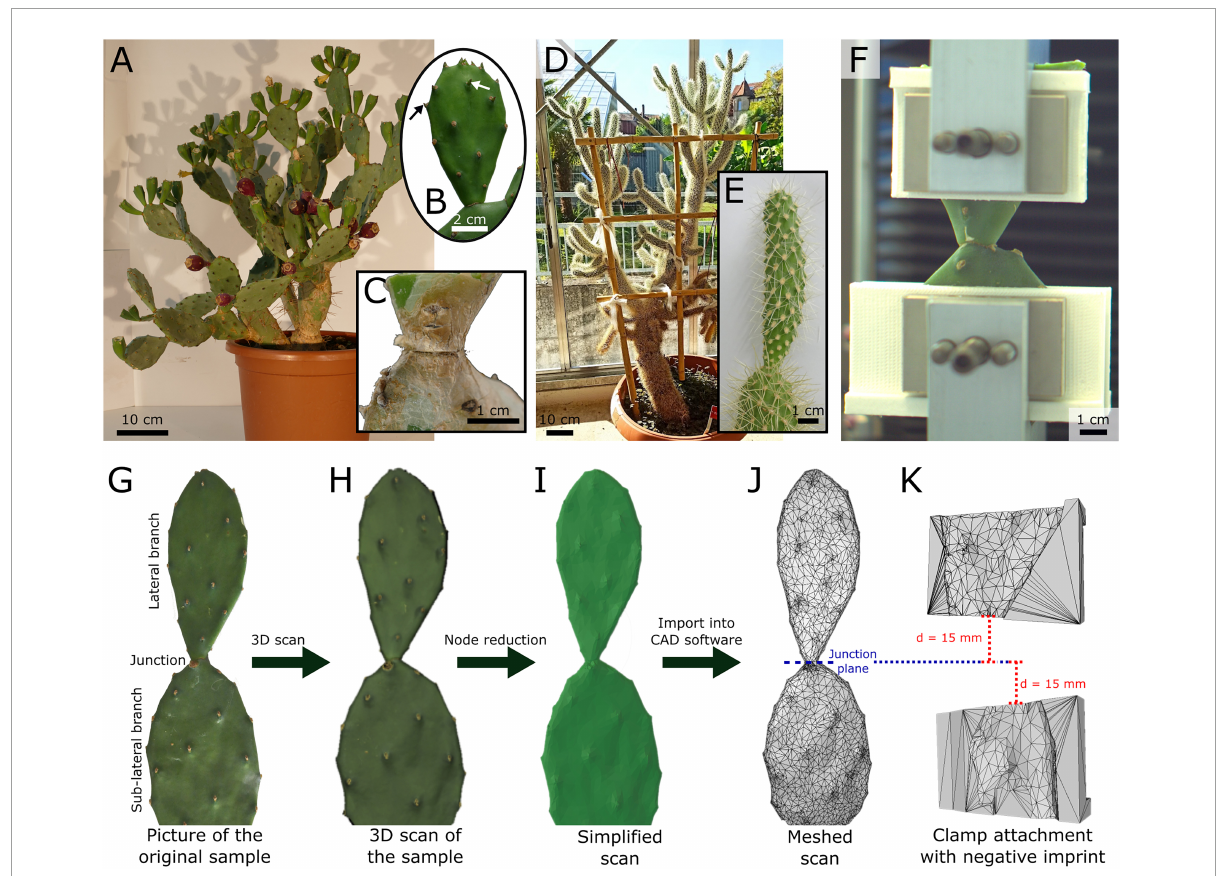
FIGURE1 (A–C) Exemplary images and representations of the experimental plants and samples of Opuntia ficus-indica and (D,E) Cylindropuntia bigelovii , (F) a front view of a junction tensile test including printed clamp attachments, and (G–K) the construction process of individualized clamp attachments for optimized form fit during the tensile tests on the junctions of O. ficus-indica . (B) Sample of O. ficus-indica classified as “young” because of as-yet unshed leaves (exemplarily marked by arrows). (C) Older lateral junction of O. ficus-indica with periderm coverage (brown tissue). (E) Lateral junction and branch of C. bigelovii . (G) Image of an O. ficus-indica sample showing the lateral and sub-lateral branches (cropped at the bottom) and the connecting junction. (H) Merged 3D scan from multiple individual scans, including surface color representation. (I) Simplified model of the scan, reduced to 10,000 nodes and without original surface color. (J) Mesh representation of the model, with the position of the junction plane marked as a reference for the alignment of the clamp attachments. (K) Mesh representation